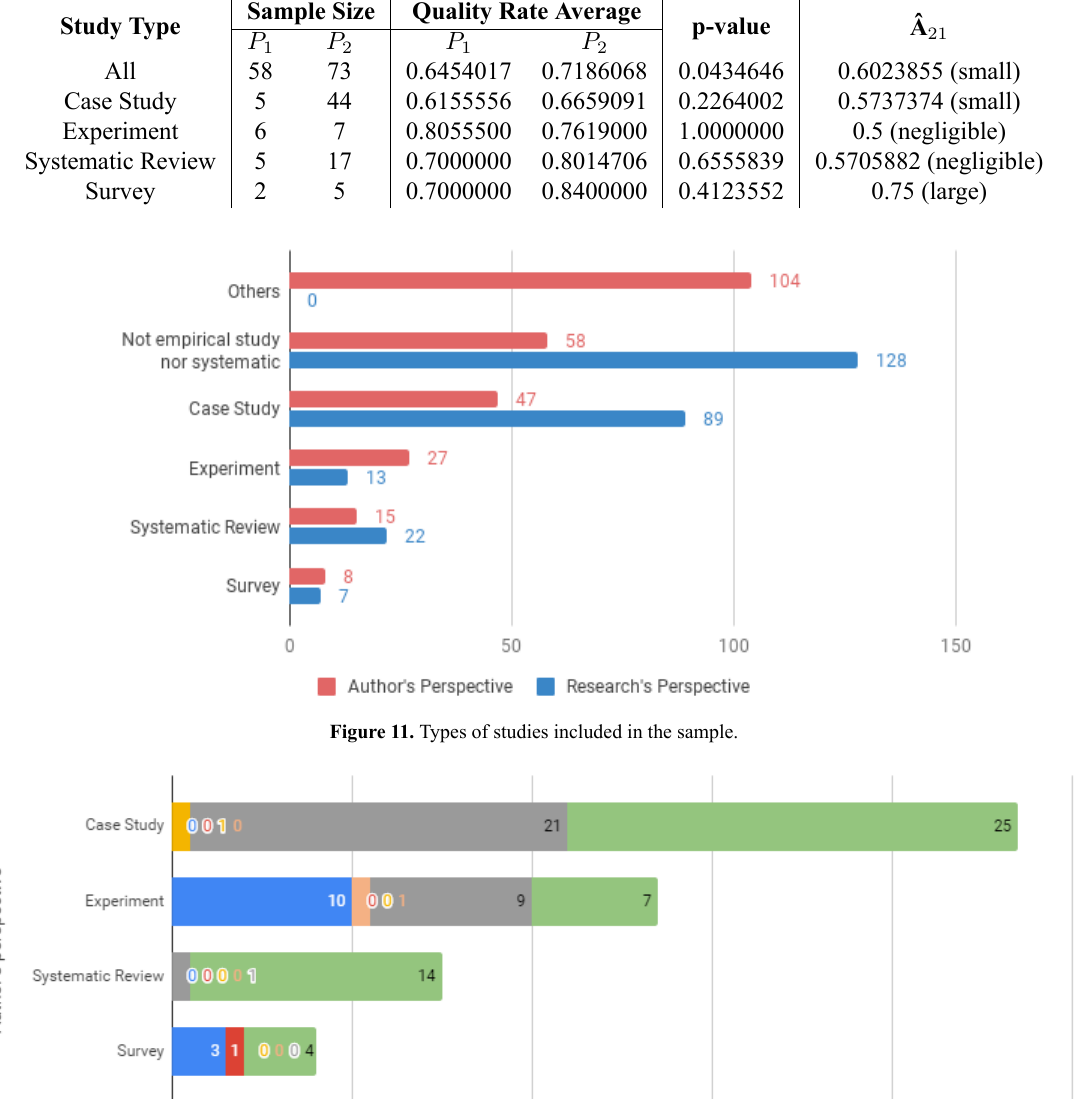
Table 6. Quality rate averages, p-values and effect sizes between P 1 (1998 to 2014) and P 2 (2015 to 2019).